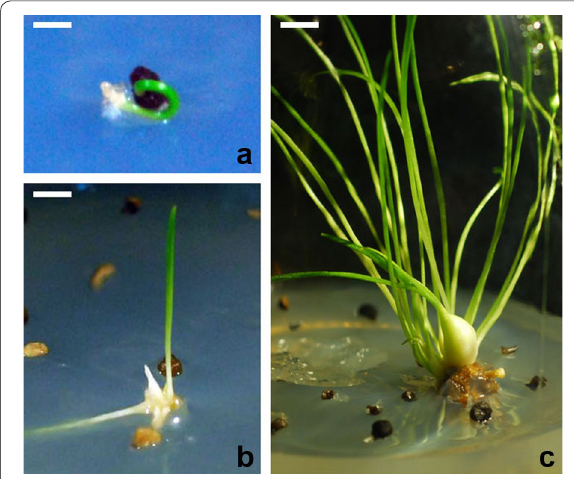
Fig. 6 Germination and plantlet formation from in vitro-rescued ovule of Lilium callosum. a In vitro-rescued ovule germination. (Bar 0.24 cm). b Cotyledon elongation and further growth of = in vitro-rescued ovule.